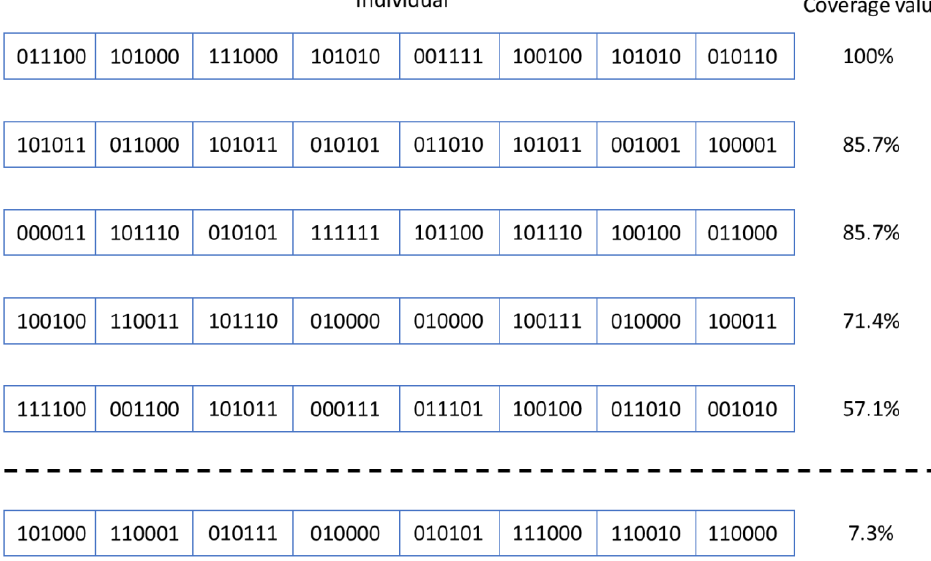
Figure 3. The individuals are ordered according their fitness function whose result is the coverage value.